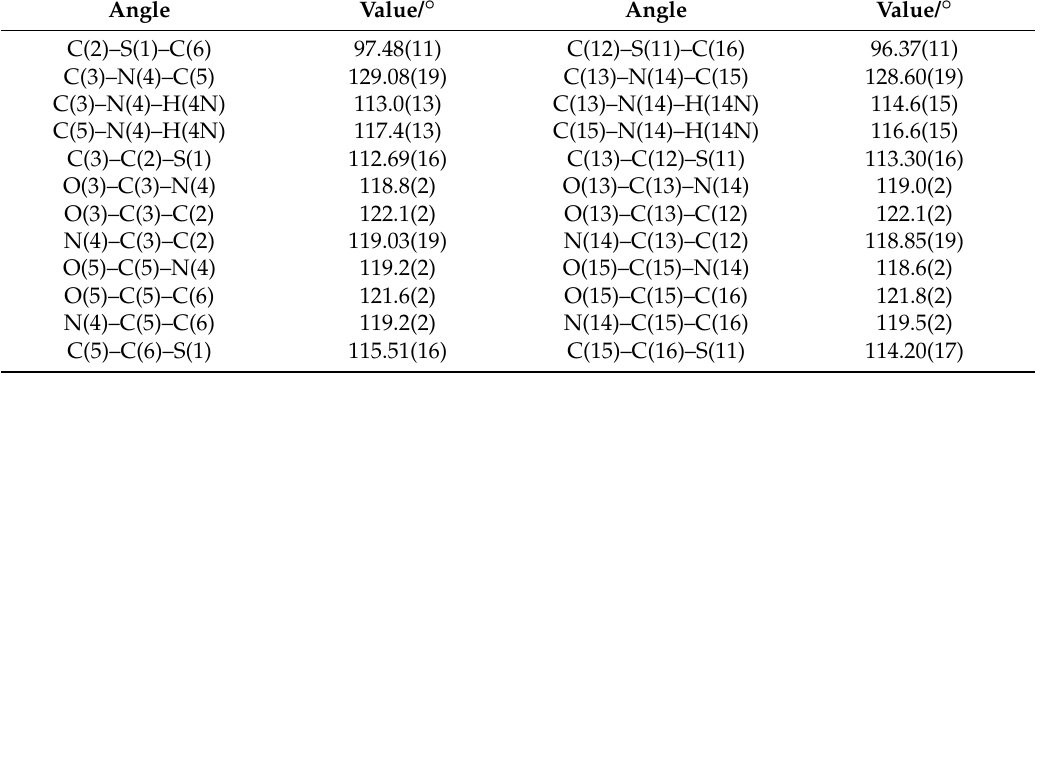
Table 2. Selected angles.